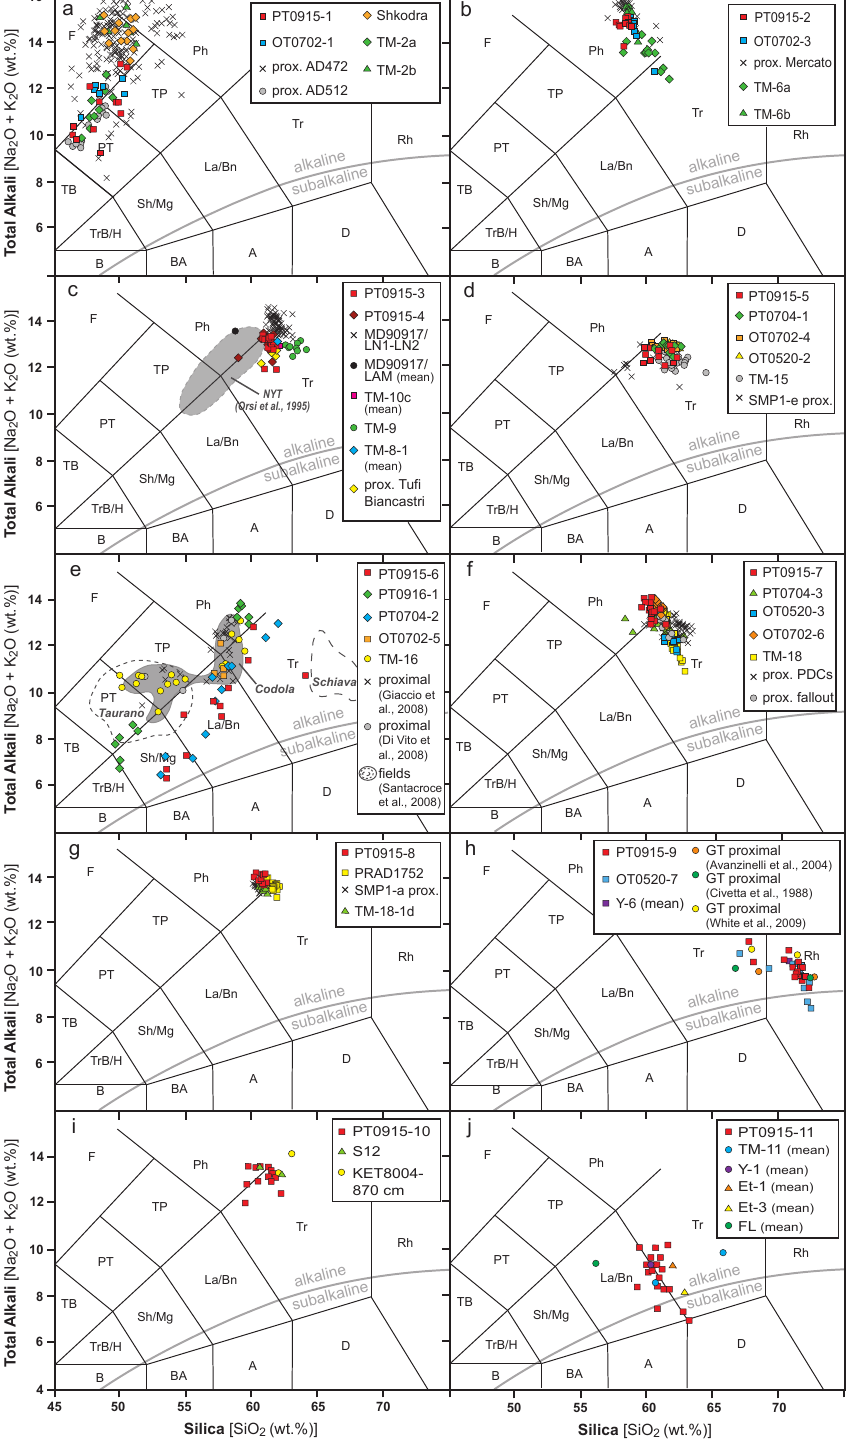
Fig. 4. Classification and correlation of tephras and cryptotephras recognised in core Co1215 from Lake Prespa (a–j) by means of the total alkali vs. silica diagram (TAS, Le Bas et al., 1986). The full set of raw data of tephras and cryptotephras identified in core Co1215 is given in Table 4 and Table S1 in the Supplement, and mean values of data used for correlation are summarised in Table S2 in the